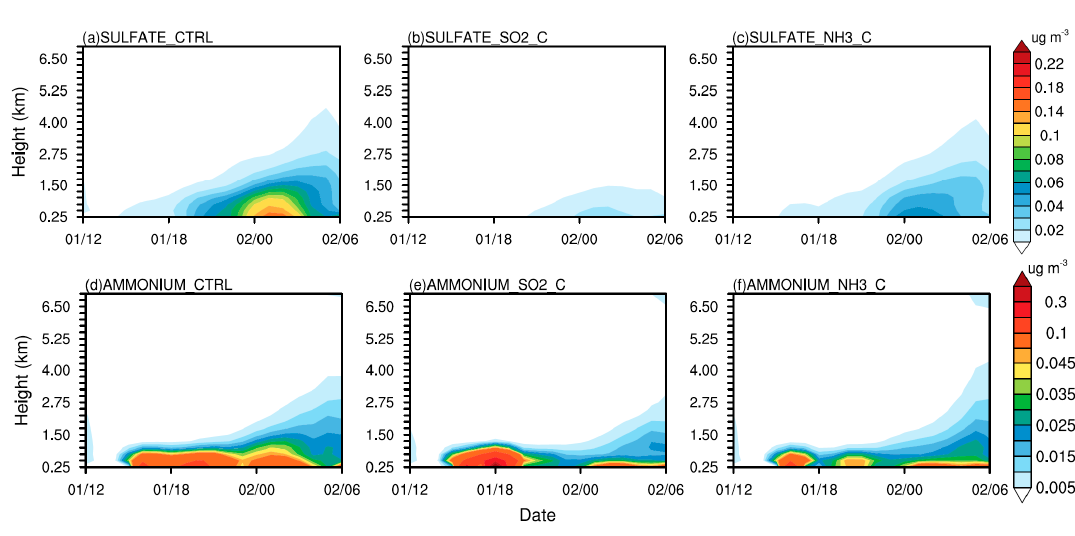
Figure 8. Time-height evolutions of area-averaged ( a – c ) SO (cid:2872)(cid:2870)(cid:2879) and ( d – f ) NH (cid:2872)(cid:2878) ( μg m (cid:2879)(cid:2871) ) within 150-km radius from the vortex center. The left, middle, and right columns represent the CTRL, SO2_C and NH3_C runs, respectively.